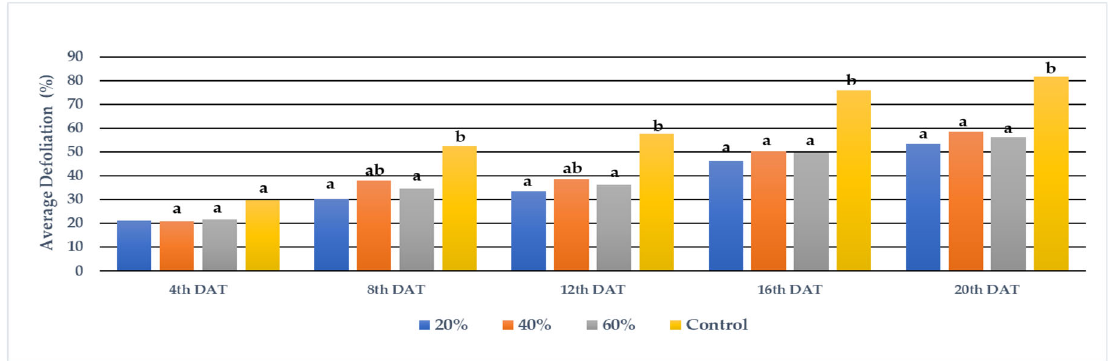
Figure 9. Average defoliation percentage on different days after defoliant application in Field 1.